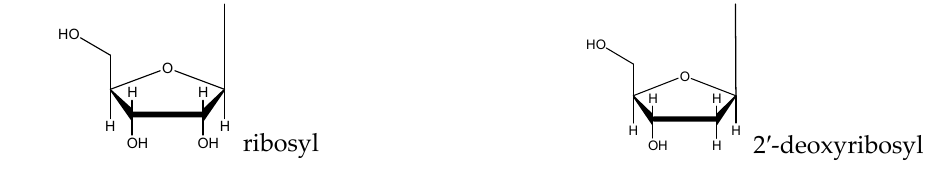
Table 2. Formation constants of nucleobase and nucleoside surface complexes (logK ± 0.05).